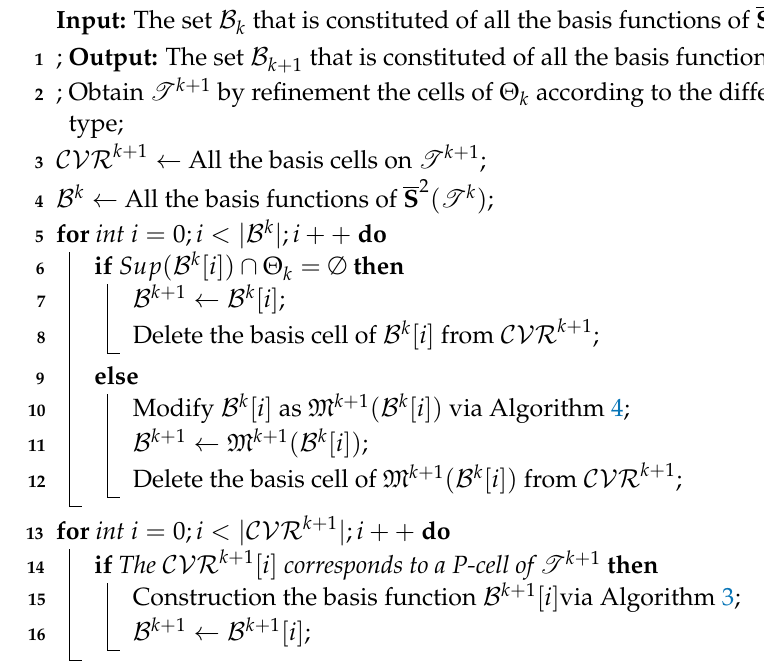
Algorithm 5: Basis construction and modification of S